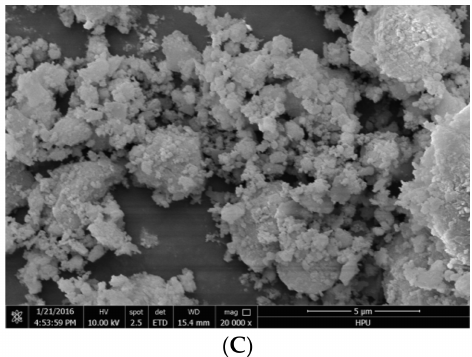
Figure 3. SEM images of NH 4 H 2 PO 4 particles ( A ), red mud ( B ), and the NH 4 H 2 PO 4 /RM composite powders ( C ).